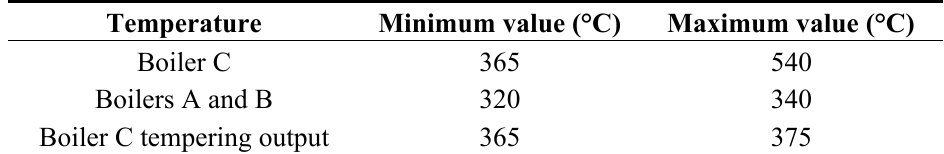
Table 3. Range of the variables for the optimization with real bounds.